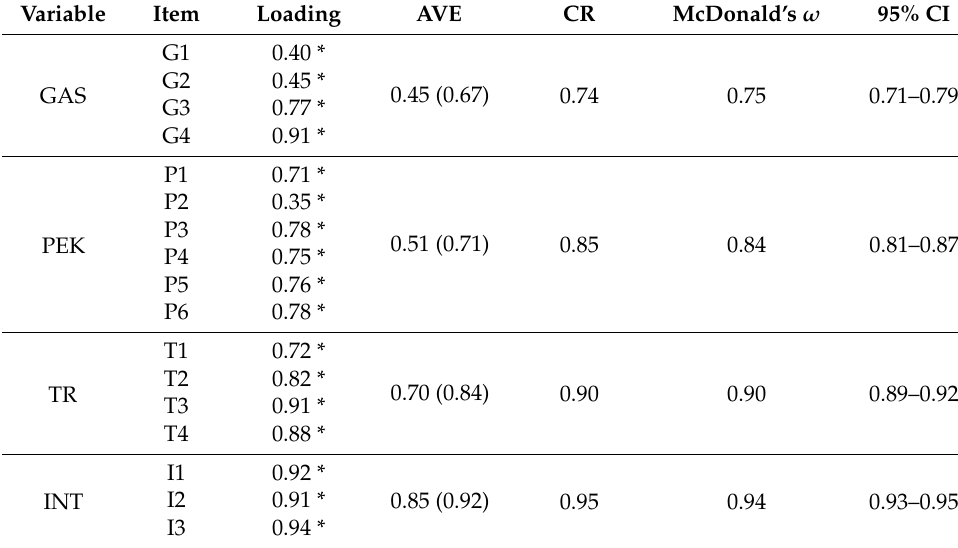
Table 4. Psychometric characteristics of measures (N =